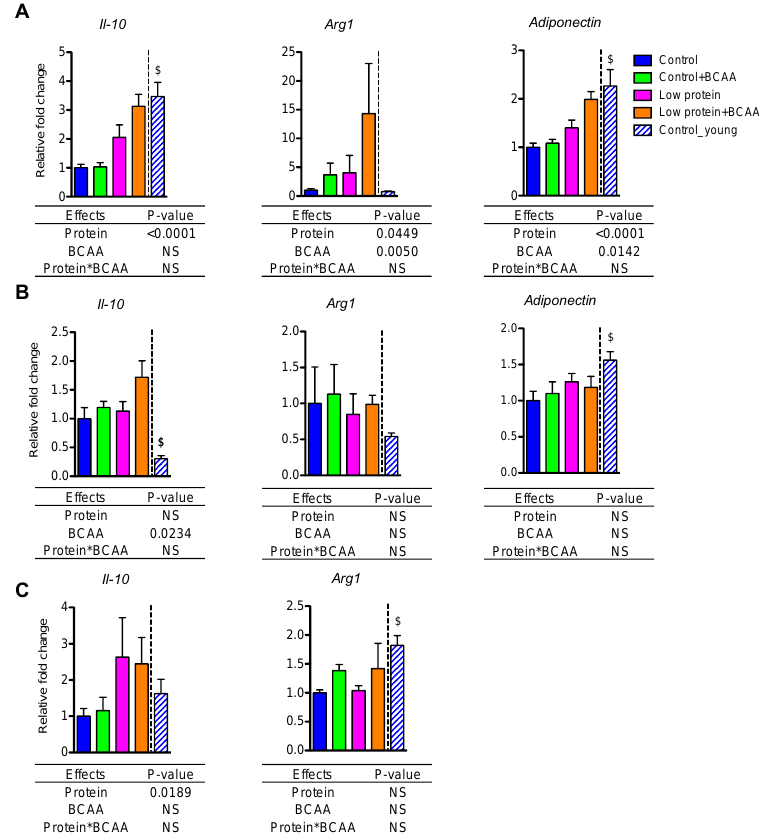
Figure 5. Dietary intervention differentially impacted anti-inflammatory gene expression in white adipose tissue and liver. The relative gene expression levels of anti-inflammatory Il-10, Arg1, and adiponectin were measured in IWAT ( A ) and EWAT ( B ) and liver ( C ). Data represent mean ± SEM ( n = 8–12 mice/group). Statistical analyses of main effects (protein and BCAA) and interactions (protein*BCAA) are shown below each graph. $ p < 0.05 for young vs. old control groups.